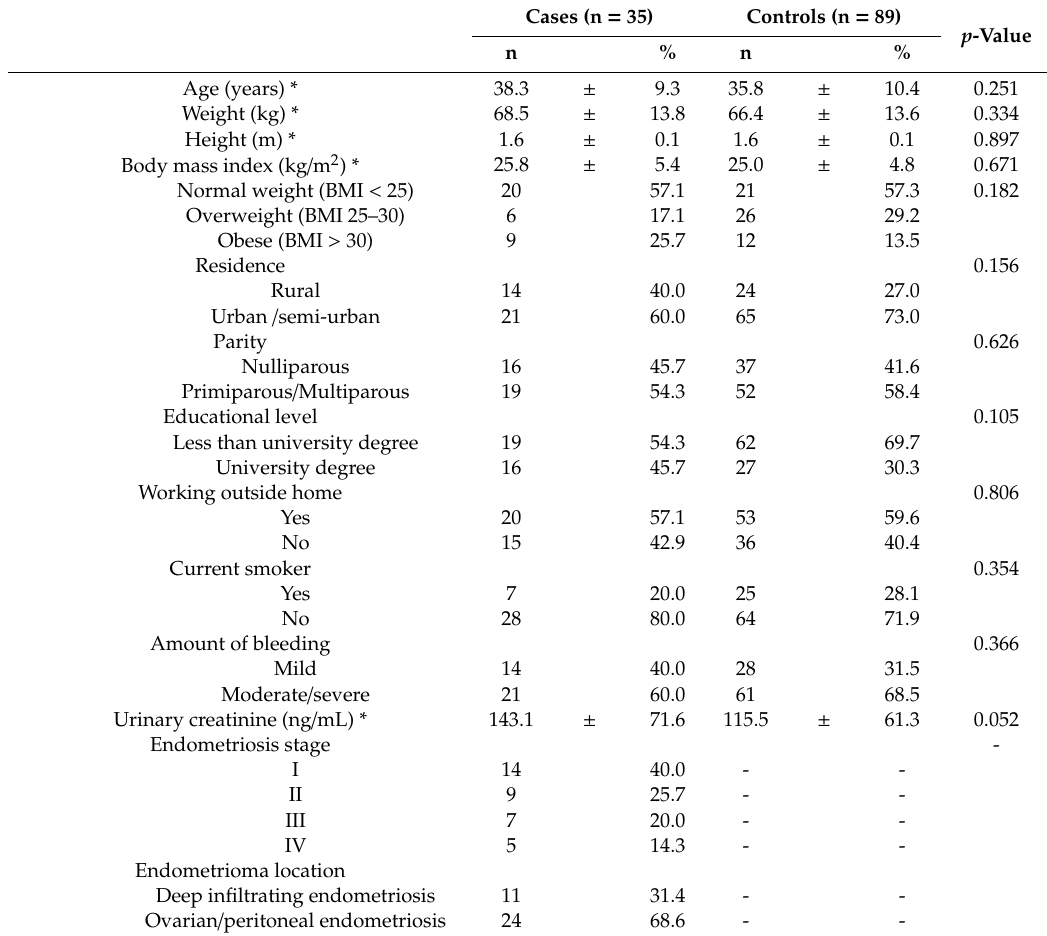
Table 1. Characteristics of the study population (n =